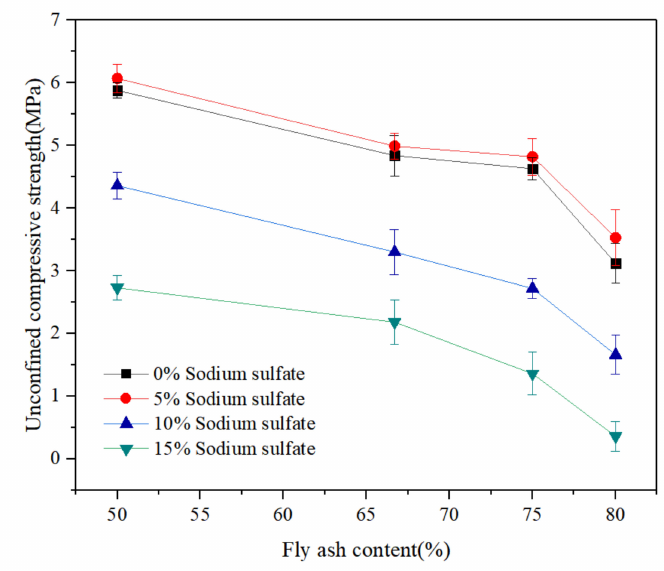
Figure 4. E ff ect of a high-sulphur fly ash content on the compressive strength under di ff erent curing